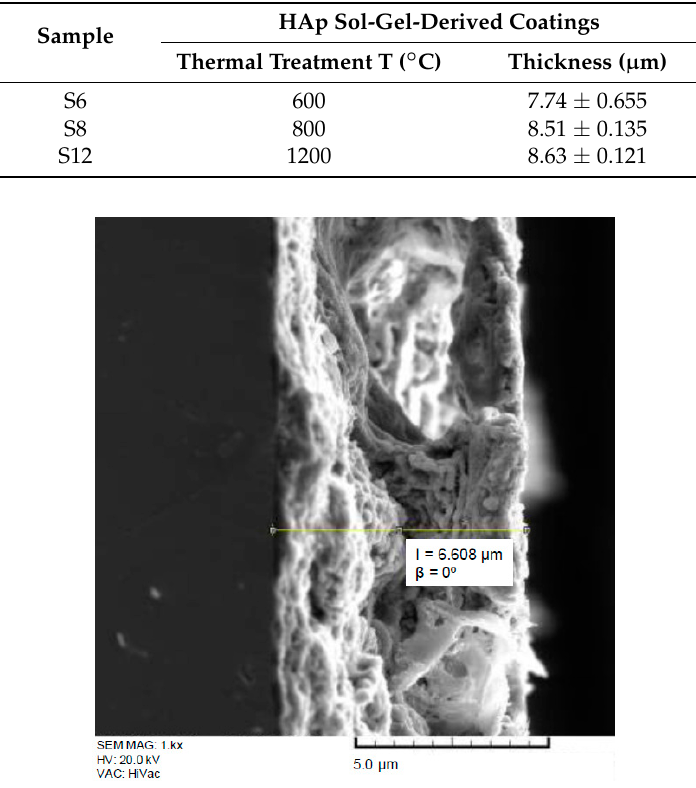
Figure 4. Cross sectional SEM image of a S6 coatings deposited on Ti6Al4V alloy.